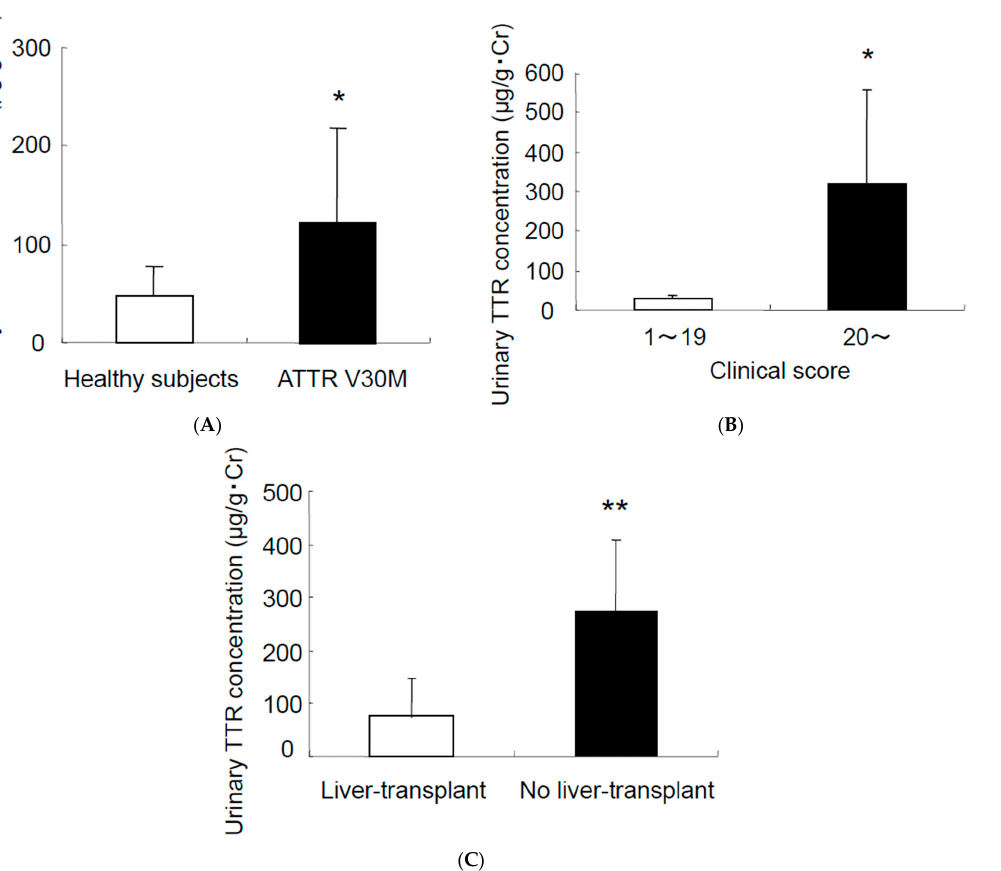
Figure 1. Urinary TTR concentrations in patients with ATTRv V50M amyloidosis. ( A ) Urinary TTR concentrations in healthy subjects ( n = 15) and in patients with ATTRv V50M amyloidosis ( n = 17). ( B ) Urinary TTR concentrations plotted against ATTRv score (1–19: n = 10, and 20: < n = 7). ( C ) Urinary TTR concentrations in patients with ATTRv V50M ( n = 12) who had liver transplants and patients with ATTRv V50M ( n = 5) but no liver transplants; * p < 0.05; ** p < 0.01. Data represent means + SD.